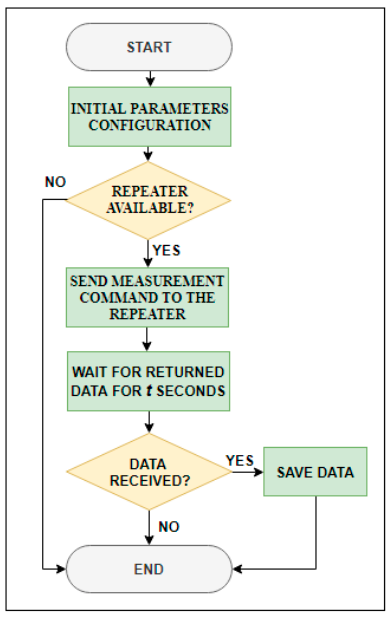
Figure 7. Gateway flow chart.